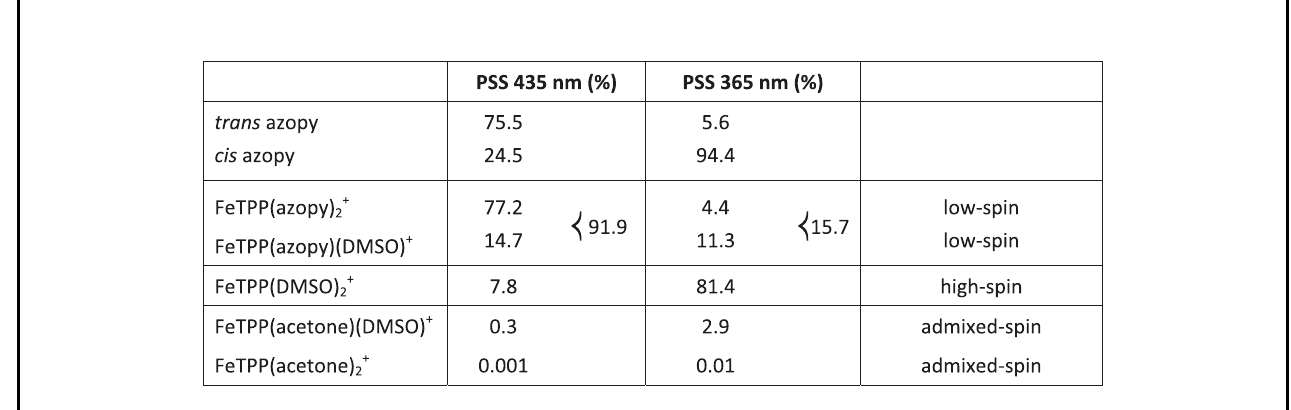
Table 1 Photostationary states of the PDL and different possible complexes of FeTPP +